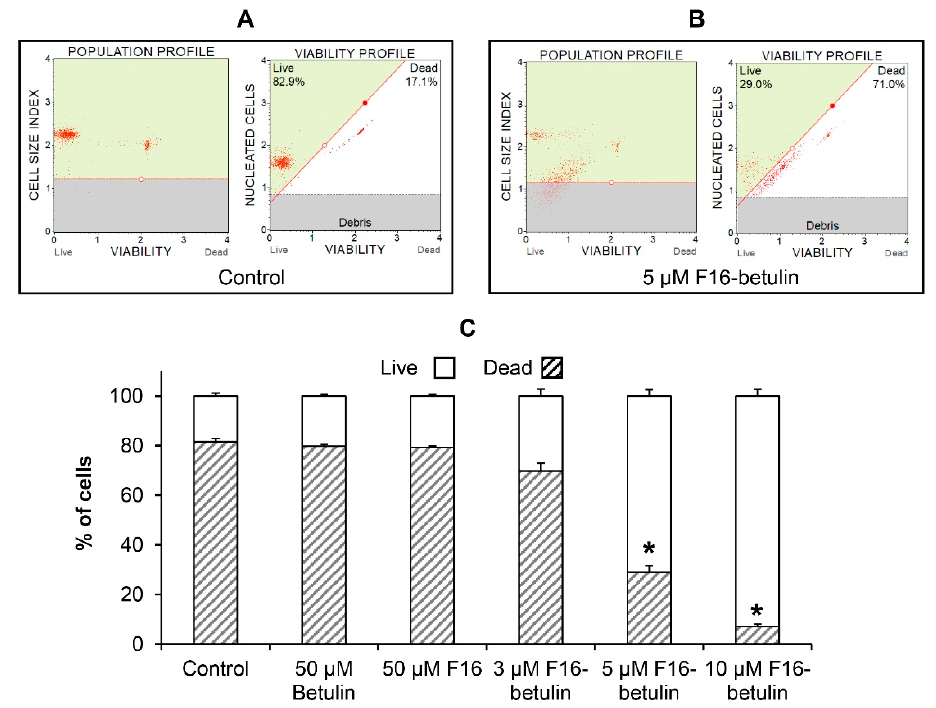
Figure 2. Cytotoxicity of the F16-betulin conjugate against rat thymocytes. Cell viability was assessed using a Muse Cell Analyzer. The upper left quadrant of the viability profile plots ( A , B ) represents healthy thymocytes, and the right quadrant shows dead ones. Typical viability profile plots are shown. A similar pattern was observed in four independent experiments. Panel ( C ) demonstrates the ratio (%) of living and dead thymocytes, mean values ± SEM (n = 4) are presented. * p < 0.05 (vs. control).